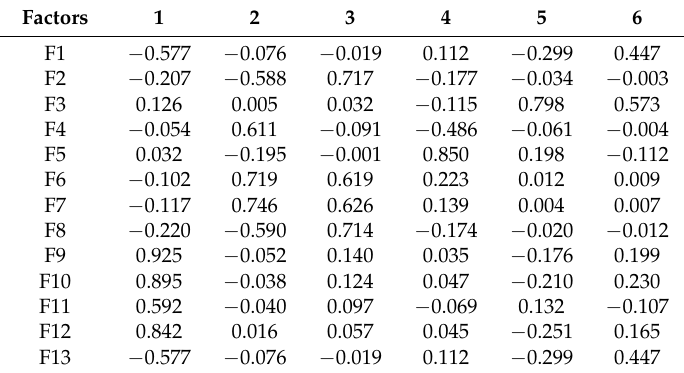
Figure 9. Influencing factors maps selected by PCA: ( a ) Factor 5 and ( b ) Factor 6. Table 6. Component score coefficient